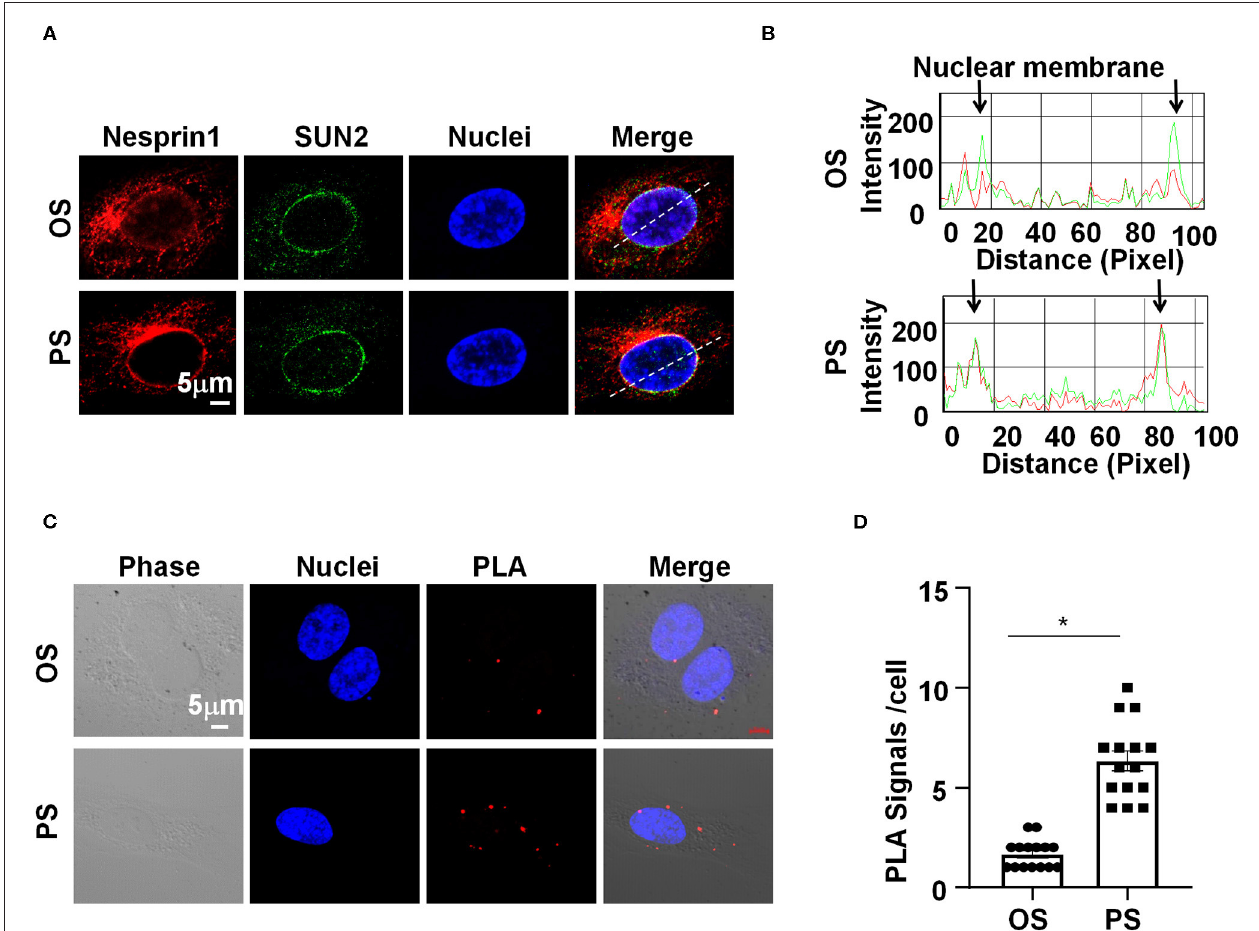
FIGURE 4 | Pulsatile shear (PS) reinforces the Nesprins-dependent cytoplasmic- and nuclear-skeleton link at the nuclear envelope. (A) HUVECs were exposed to PS or OS for 6h, and the localizations of Nesprin1 and SUN2 were analyzed by Immunofluorescence staining. (B) Fluorescence intensity profiles of (A) analyzed using Image-Pro Plus indicate the degree of overlap between Nesprin1 and SUN2. (C) HUVECs were exposed to PS or OS for 6h, and the association between Nesprin1 and SUN2 was analyzed by PLA. (D) Quantification of (C) . Each symbol represents one cell. Unpaired t -test. * P < 0.05 compared with the indicated